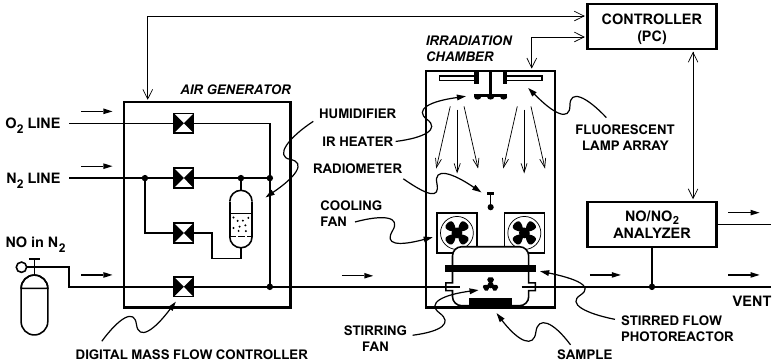
Figure 1. Experimental system for the measurement of the photocatalytic degradation of NO at ambient conditions and a constant NO concentration.